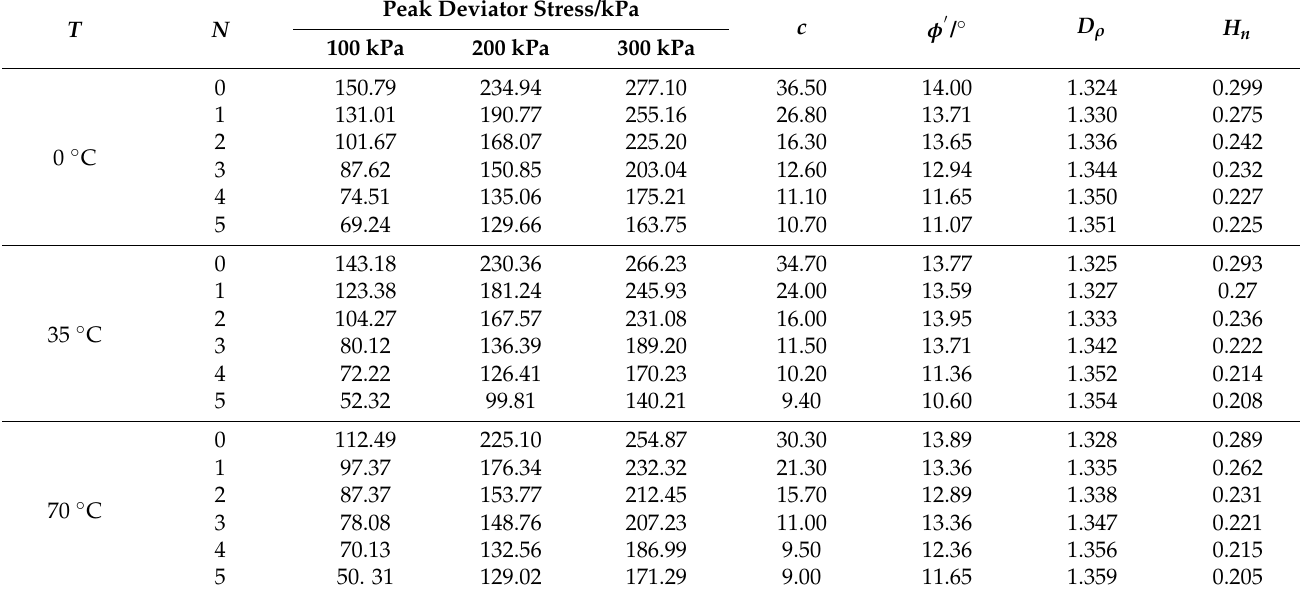
Table 3. The parameters of peak deviator stress and shear